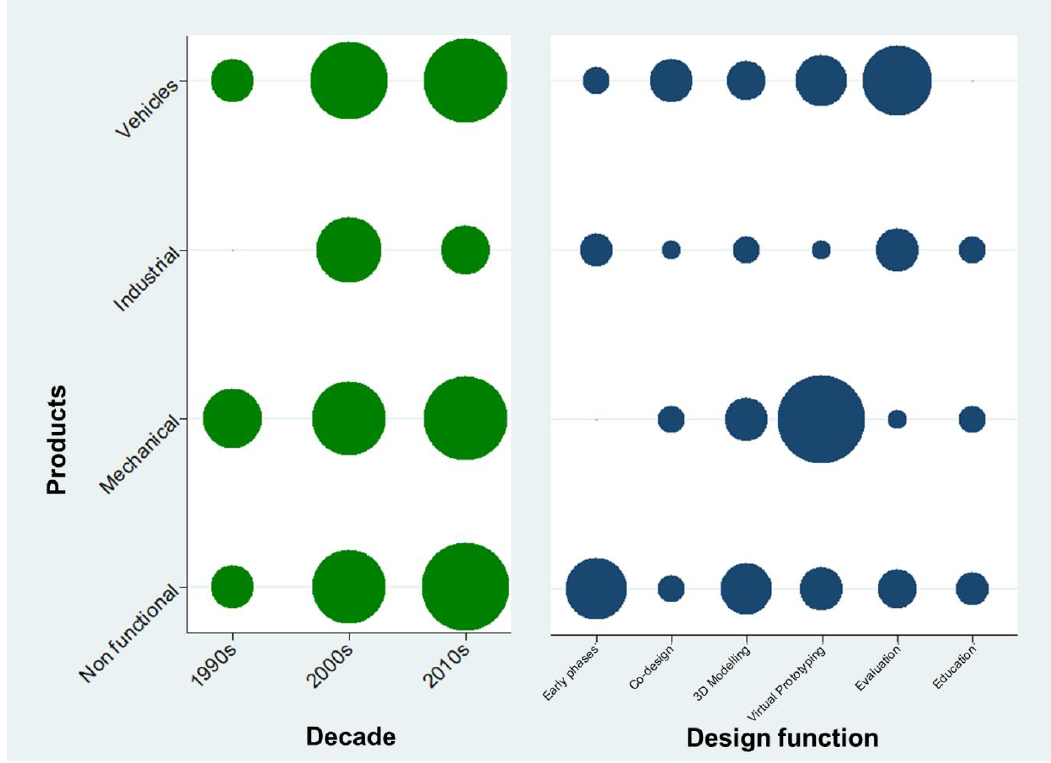
Figure 8. Product categories used in VR applications in design and their distribution across decades and design functions.